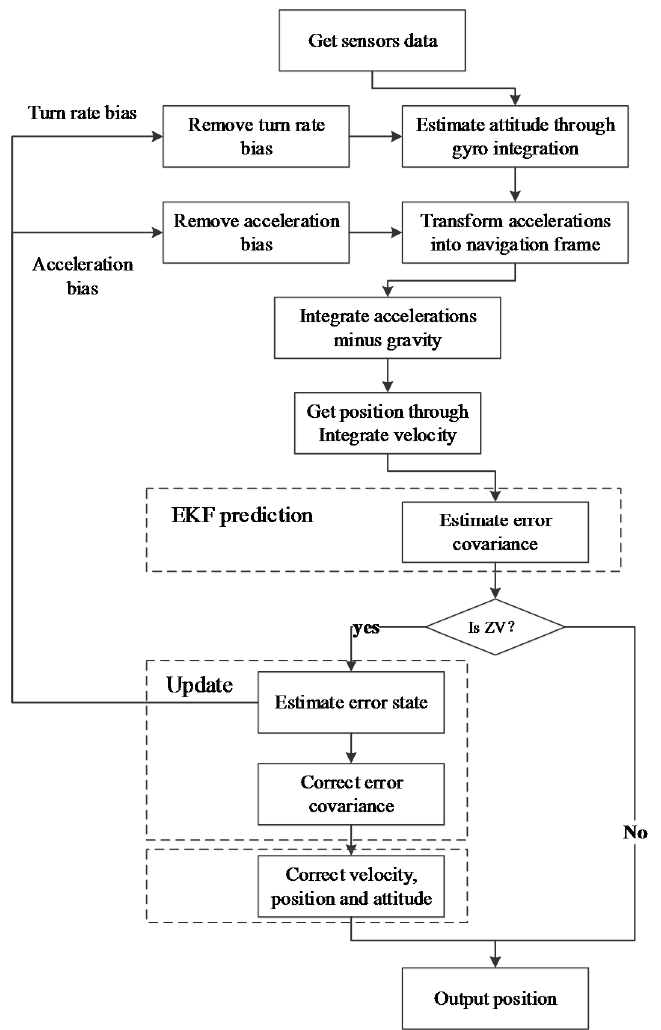
Figure 8. The EKF framework used for